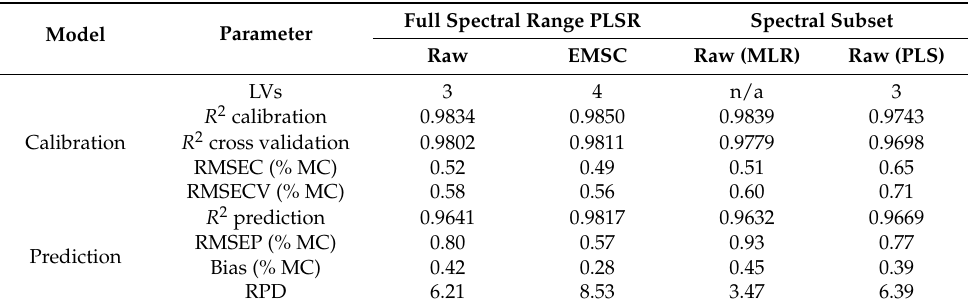
Table 2. Statistical parameters of the developed prediction models for moisture content (MC) in green coffee beans using near infrared spectra.